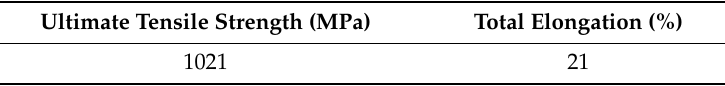
Table 2. Mechanical properties of base metal used in this study.